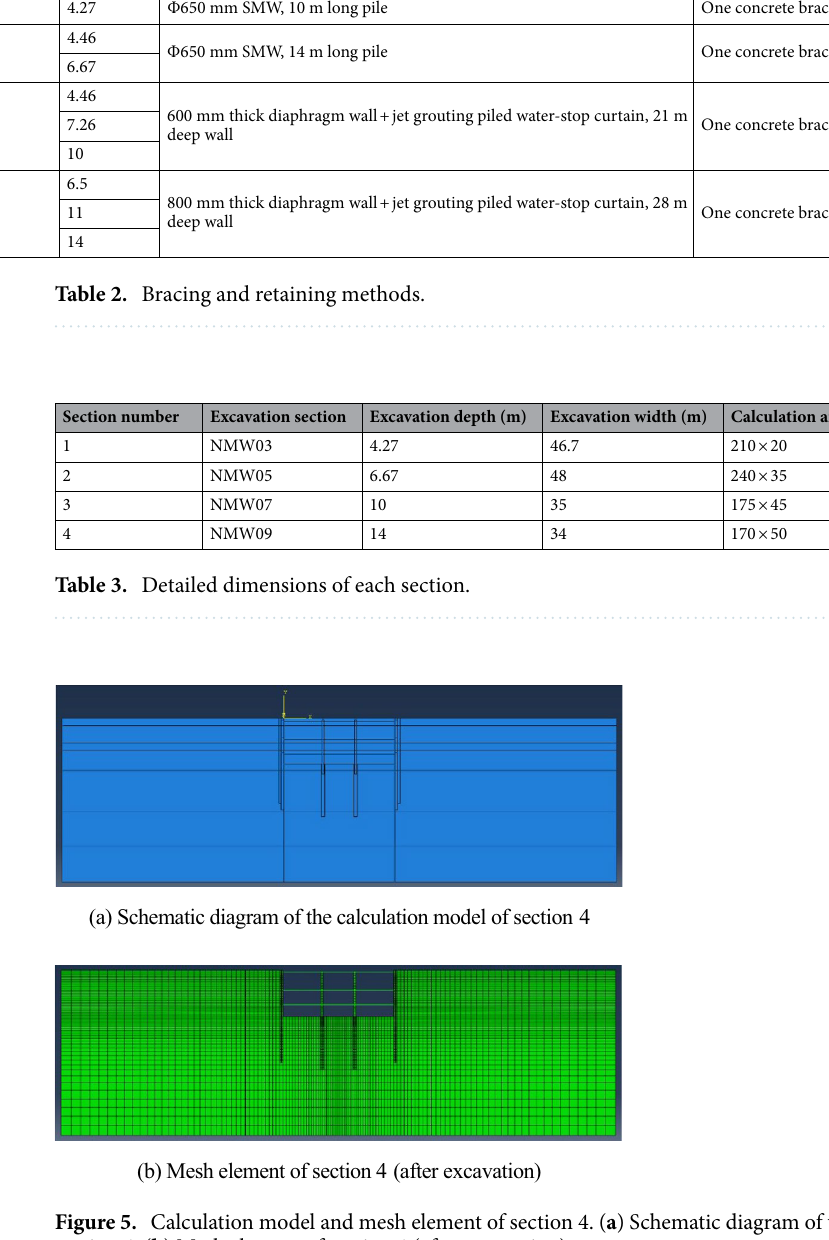
Figure 5. Calculation model and mesh element of section 4. ( a ) Schematic diagram of the calculation model of section 4. ( b ) Mesh element of section 4 (after excavation).